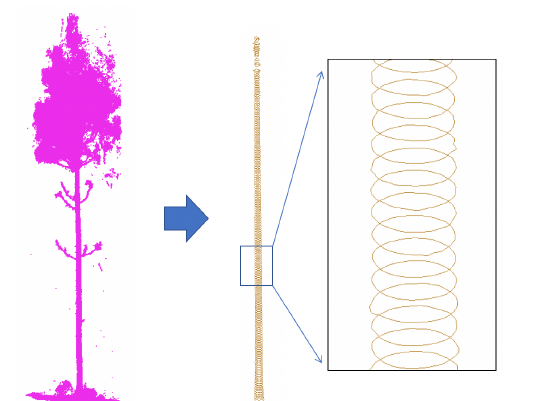
Table 4. Volume in each height range for tree No. 5